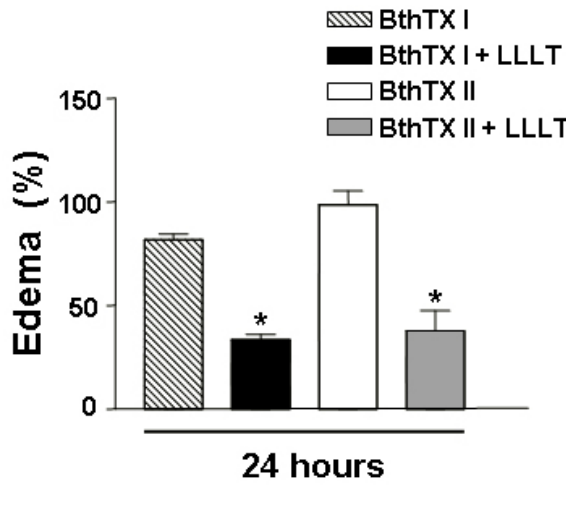
Figure 1 . Edema induced by BthTX-I (diagonally striped bar), BthTX-II (empty bar), and treatment with LLLT (black and gray bars). * p < 0.05 versus the corresponding myotoxin group; # p < 0.05 BthTX-II versus